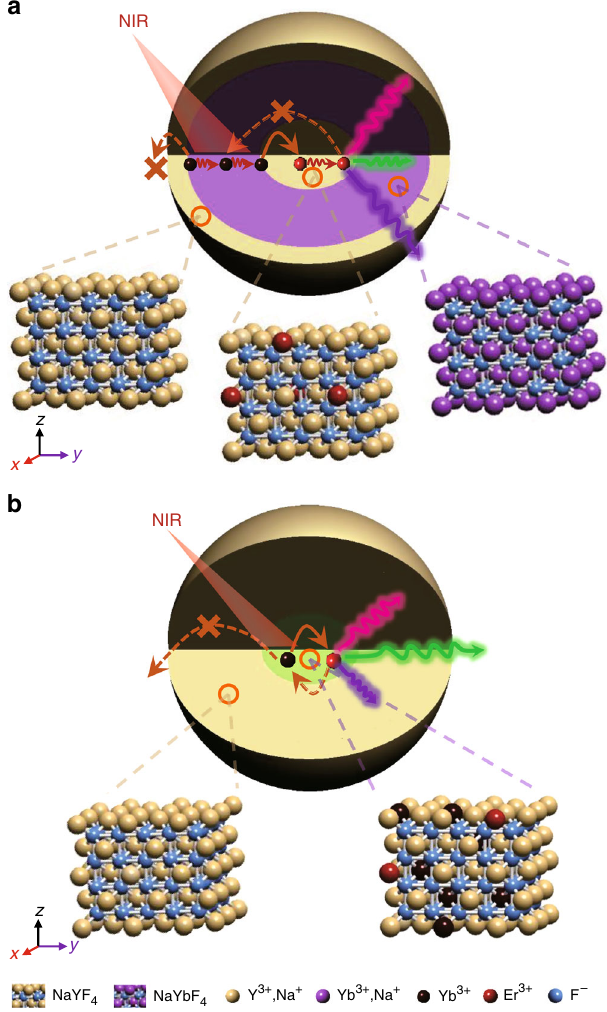
Fig. 1 Schematic diagram for the UCNPs showing principle emissions. a α -NaYF 4 :Er@NaYbF 4 @NaYF 4 core-shell-shell nanoparticles. b α - NaYF 4 :20% Yb, 2% Er@NaYF 4 core-shell nanoparticles. Both